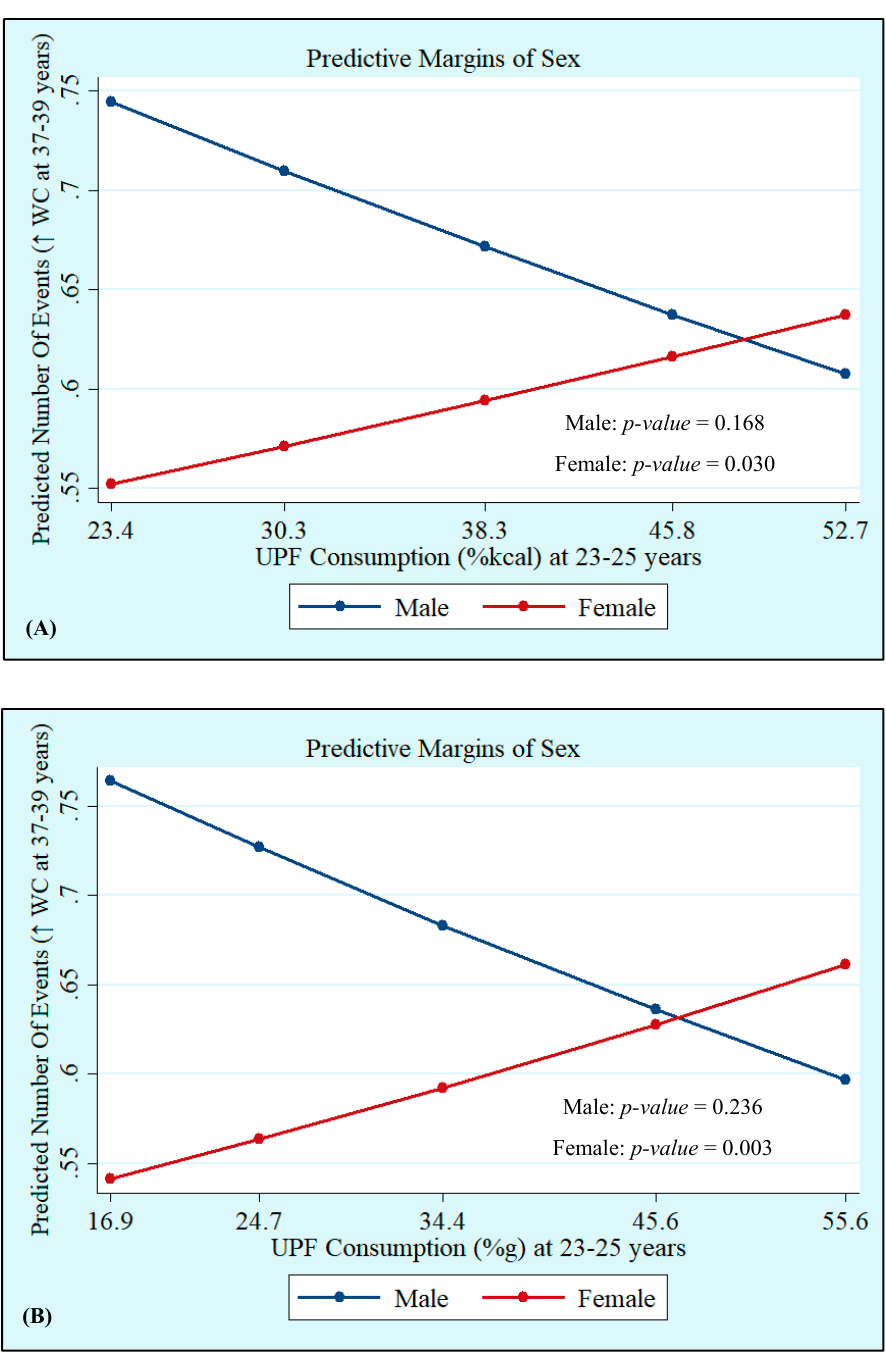
Figure 1. Incidence of high waist circumference (WC) at 37–39 years by sex according to ultra-processed food (UPF) consumption in %kcal ( A ) and %g ( B ) at 23–25 years. Ribeirão Preto Cohort 1978/79, São Paulo, Brazil.